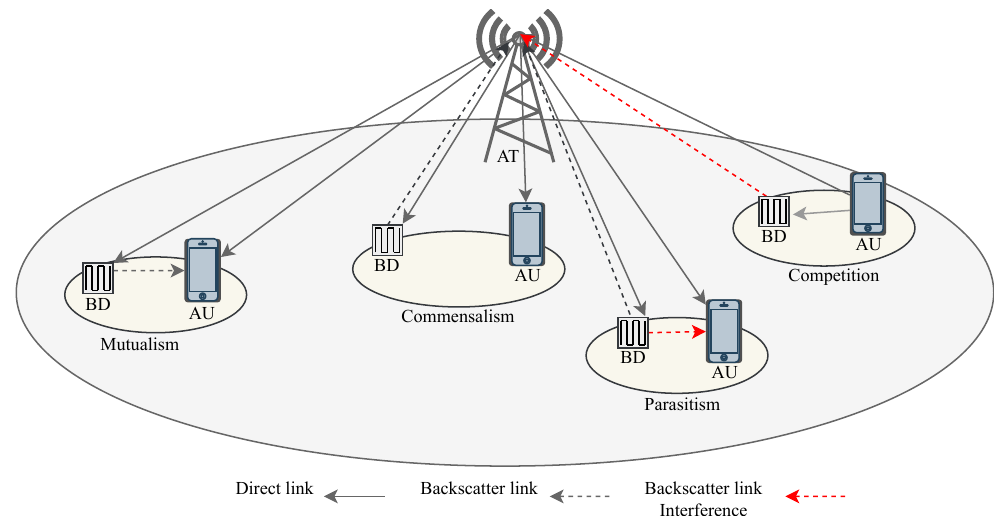
Figure 5. SRad system with different symbiotic relationships between BD and AU for resource